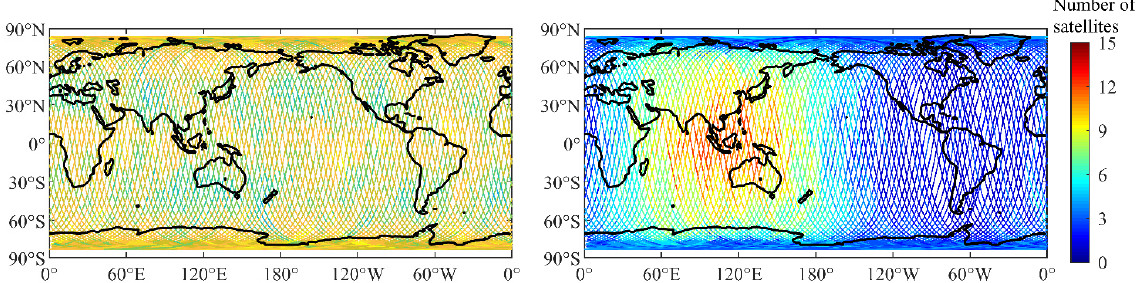
Figure 3. Average number of GPS ( left panel ) and BDS2 ( right panel ) satellites observed along TH-2A orbits from DOY 305 to 310 in 2019.